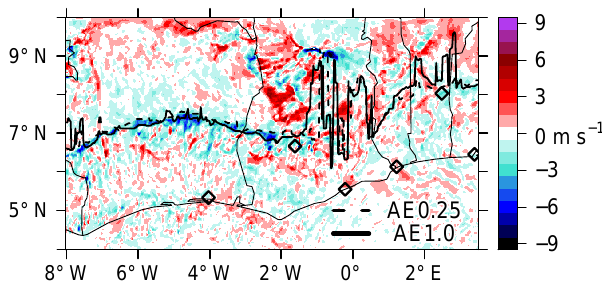
Figure 9. Wind speed difference at 250ma.g.l. on 2 July 22:00UTC (ms − 1 ) between the reference and the clean case. The black dashed (solid) line shows the AI front for the clean (reference) case.